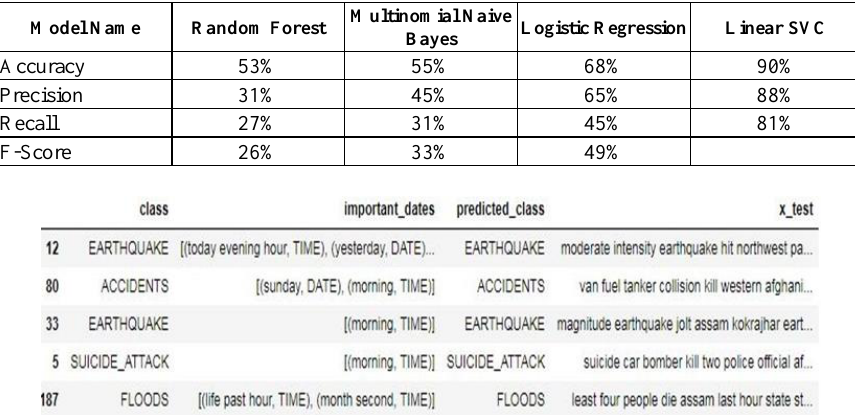
Fig. 4. Snapshot of the output table after testing is done